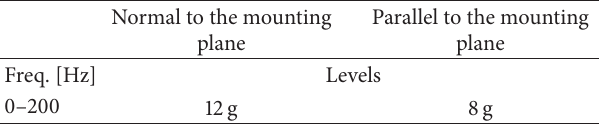
Table 2: Qualification loading levels.